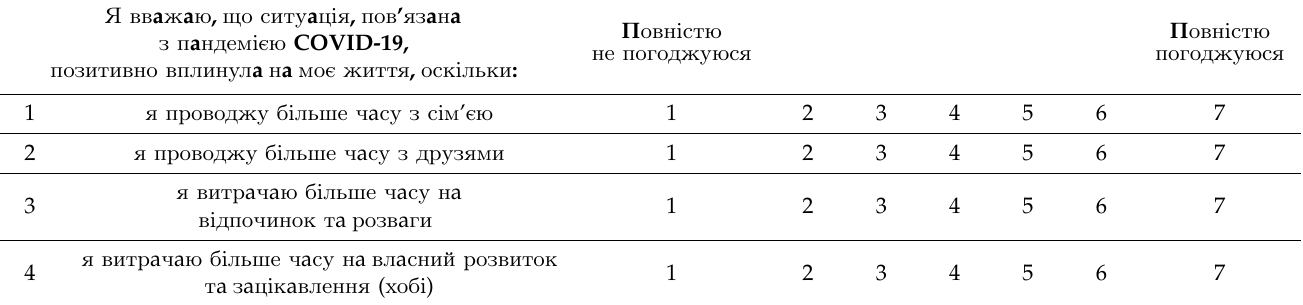
Table A3. Шк a л a сприйняття позитивного впливу локд a уну ( Ш C Π B Л-